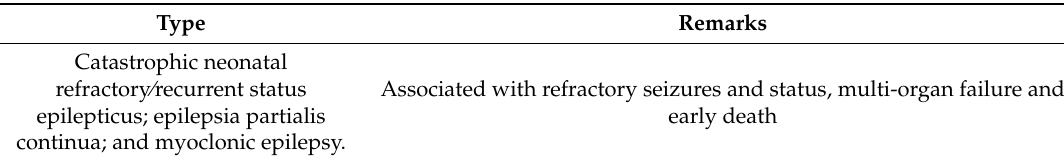
Table 4. Phenotypes of epilepsy associated with mitochondrial disease